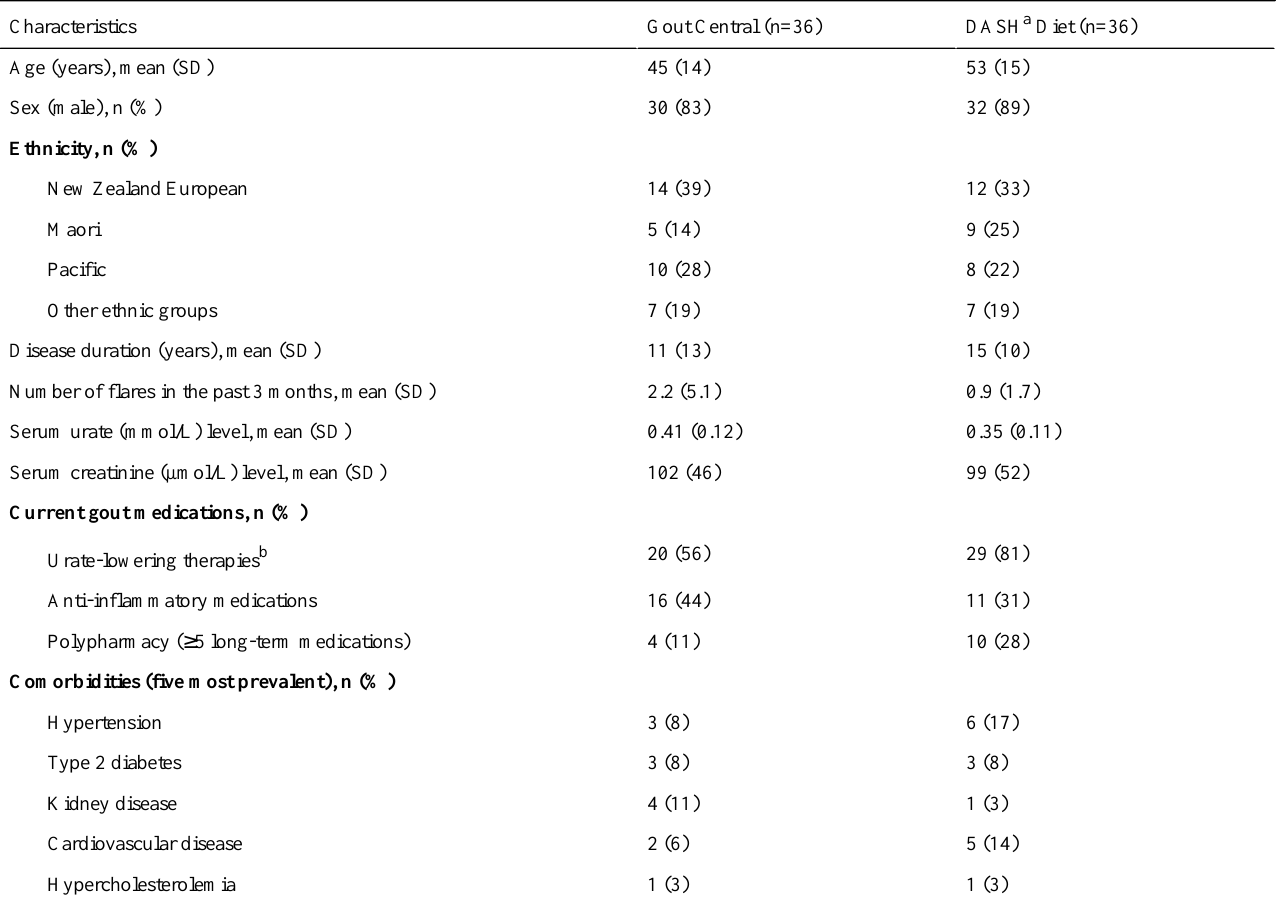
Table 1. Baseline demographic and clinical characteristics